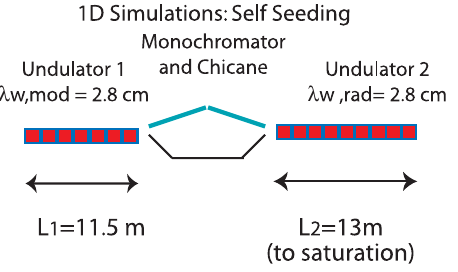
FIG. 3. (Color) Layout of the HGHG system for the 1D simu-